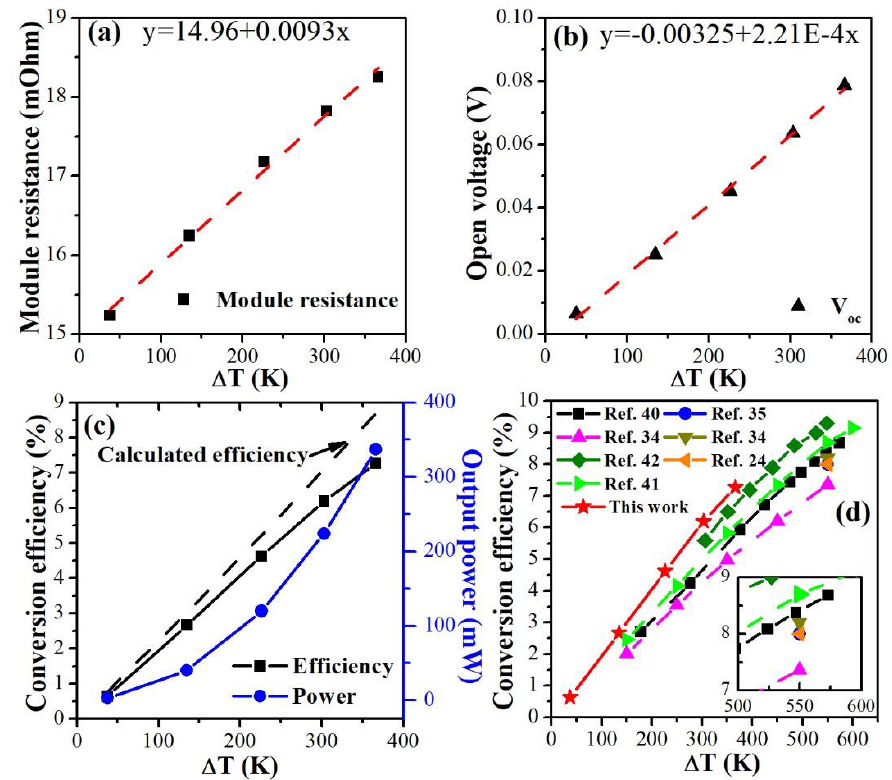
Figure 6. ( a ) The internal resistance, ( b ) open voltage, ( c ) conversion efficiency and output power of